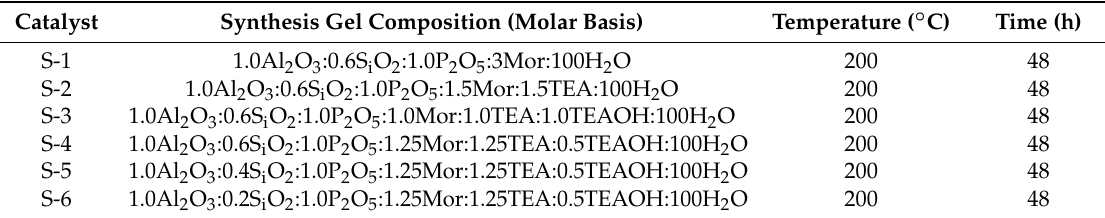
Table 8. The gel composition and experimental synthesis conditions for the different SAPO-34 materials. Catalyst Synthesis Gel Composition (Molar Basis)